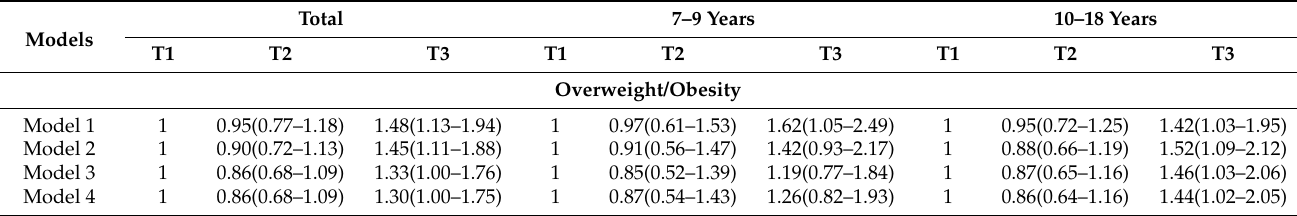
Table 4. Odds ratios for overweight/obesity and abdominal obesity according to tertiles of sodium intake among Chinese children and adolescents aged 7–18